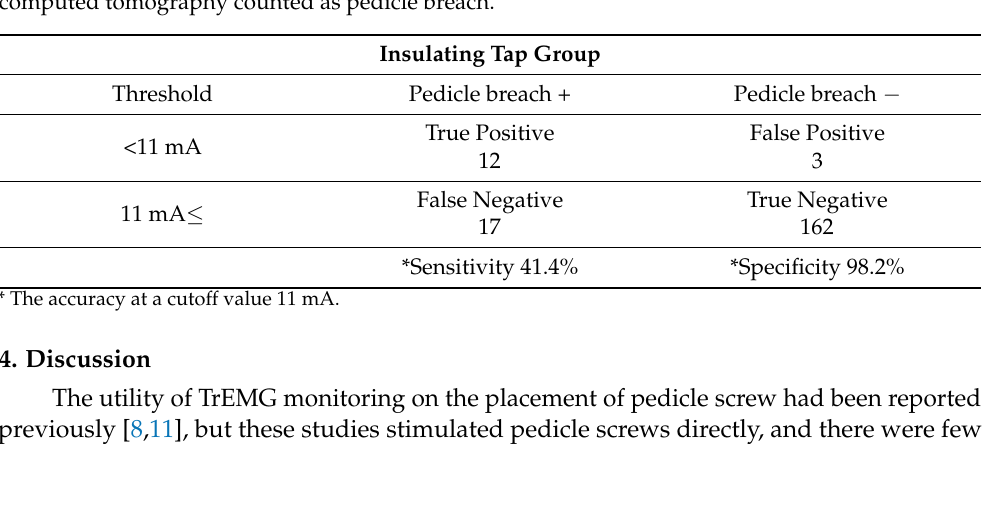
Table 5. The sensitivity and specificity of TrEMG including 3 cases of pedicle fracture on postoperative computed tomography counted as pedicle